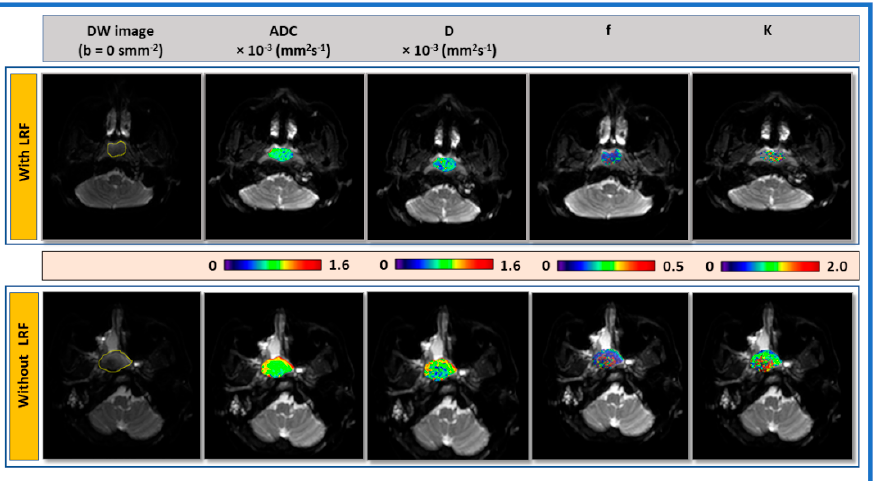
Figure 2. Representative pre-treatment (TX) diffusion-weighted (DW) images (b = 0 s/mm 2 ) and parametric maps of apparent diffusion coefficient (ADC), true diffusion coefficient ( D ), perfusion fraction (f), and kurtosis coefficient ( K ) in patients with (48-year-old male) and without locoregional failure (LRF) (55-year-old male) of nasopharyngeal carcinoma (top and bottom). Primary tumor parametric maps are overlaid on pre-TX DW images (b = 0 s/mm 2 )